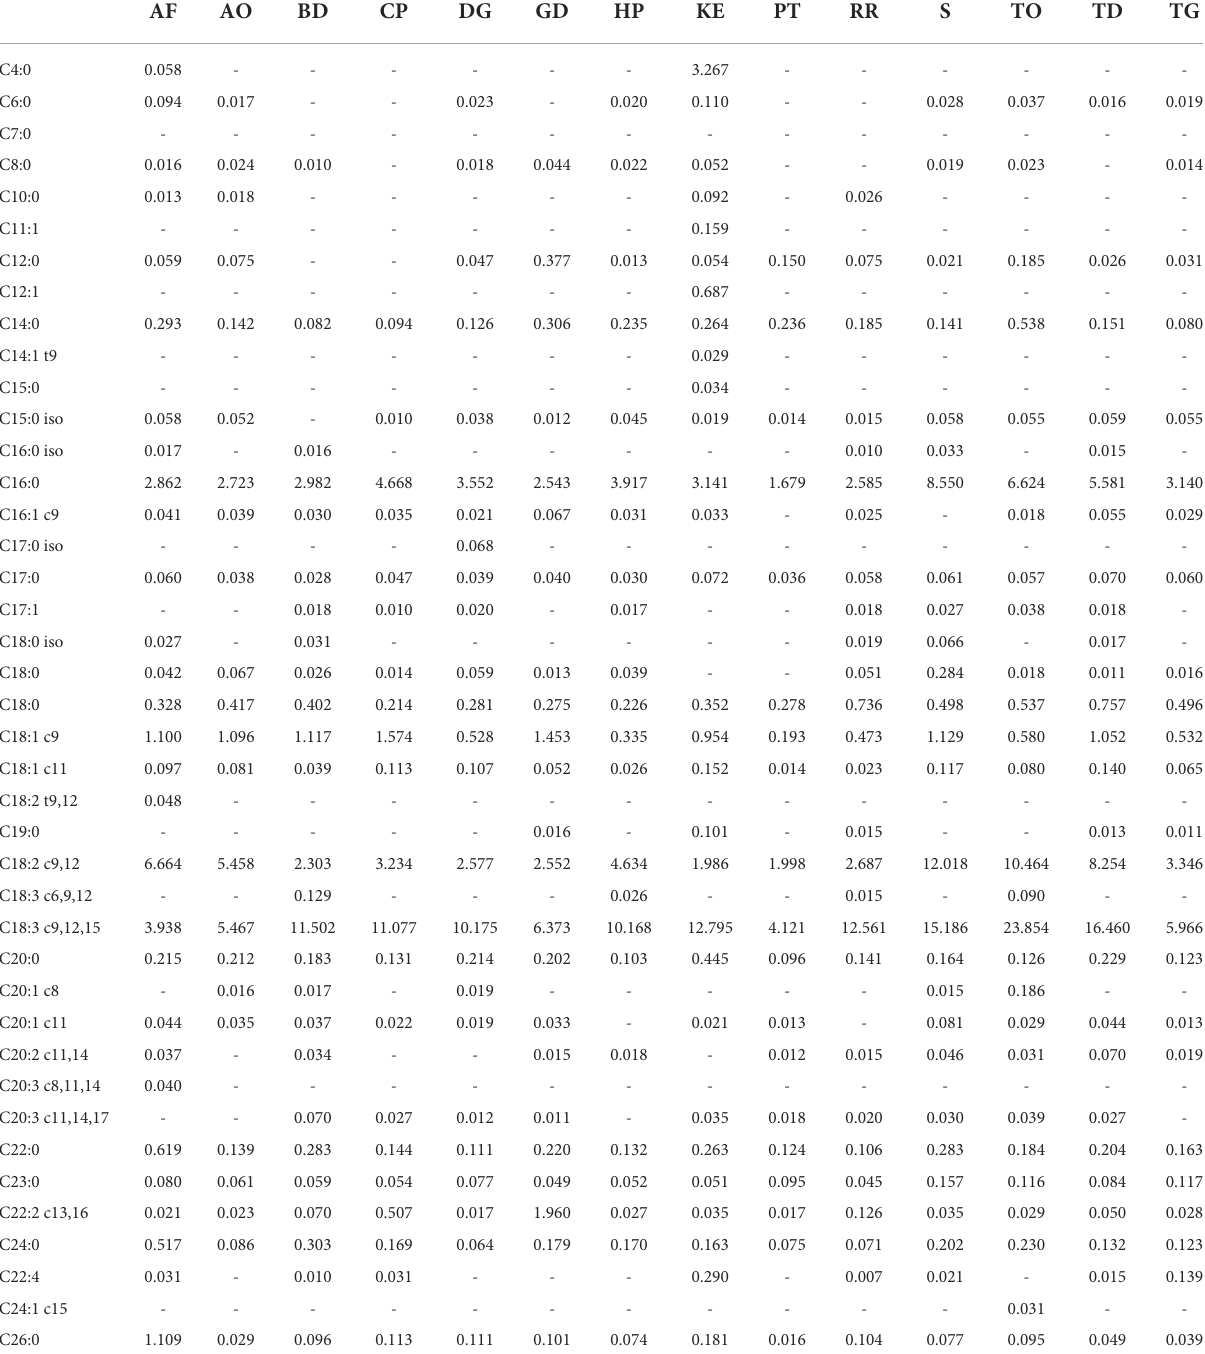
TABLE 5 Fatty acid composition as methyl esters (FAME) (in mg/g of dried sample) of 14 plants purposely selected in terms of phytochemical and nutraceutical composition. AF AO BD